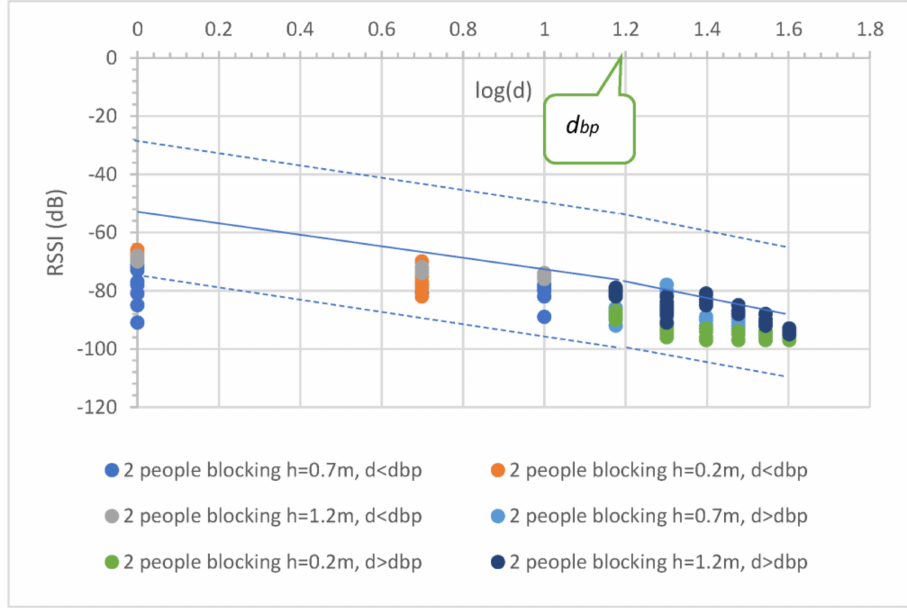
Figure 12. FLR curves for RSSI with two people blocking at membership level